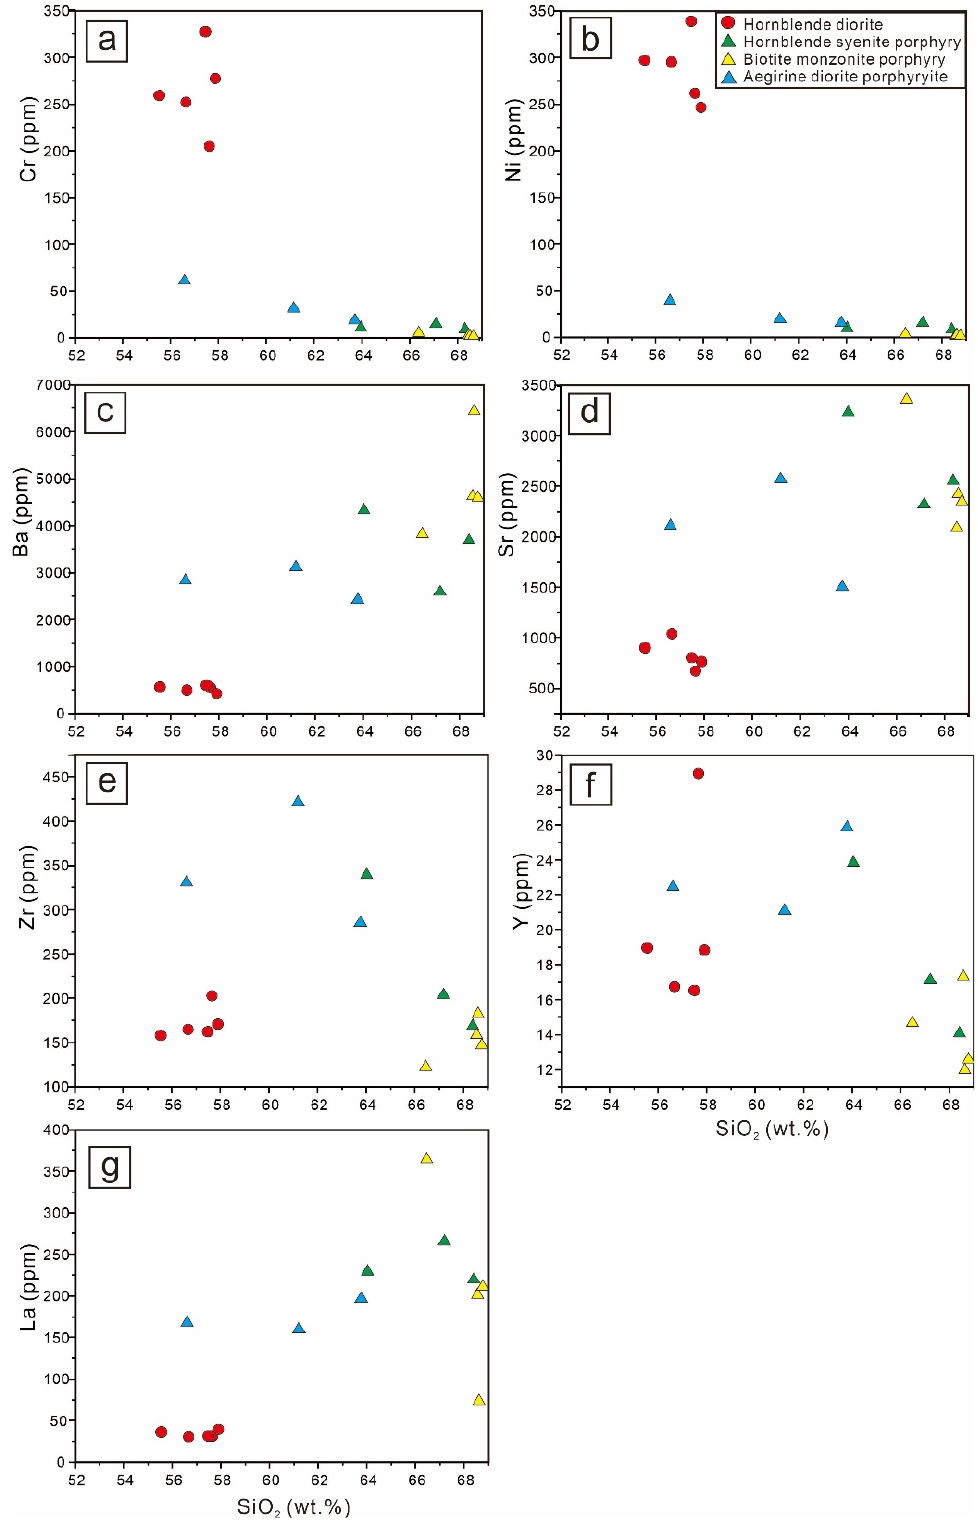
Figure 9. Harker diagrams for trace elements of Longbaoshan alkaline